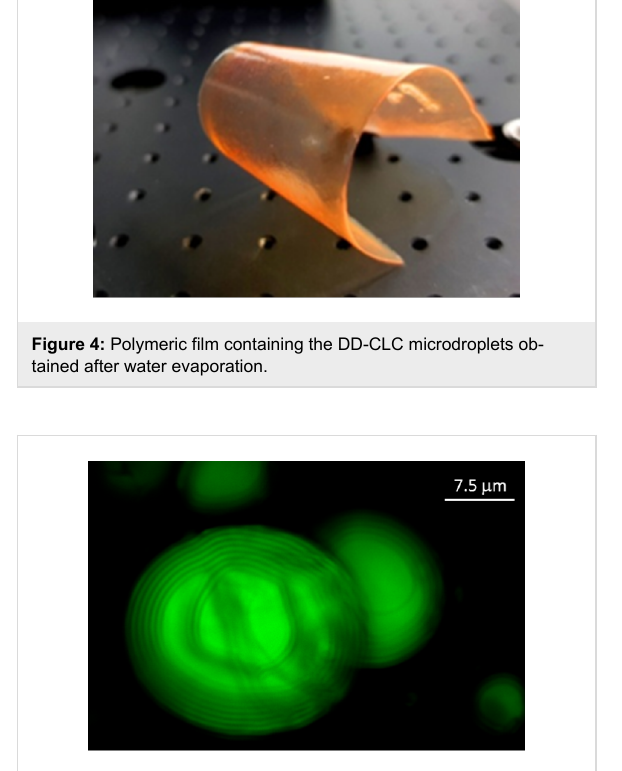
Figure 5: Confocal micrograph of two DD-CLC microdroplets confined in a polymeric film.